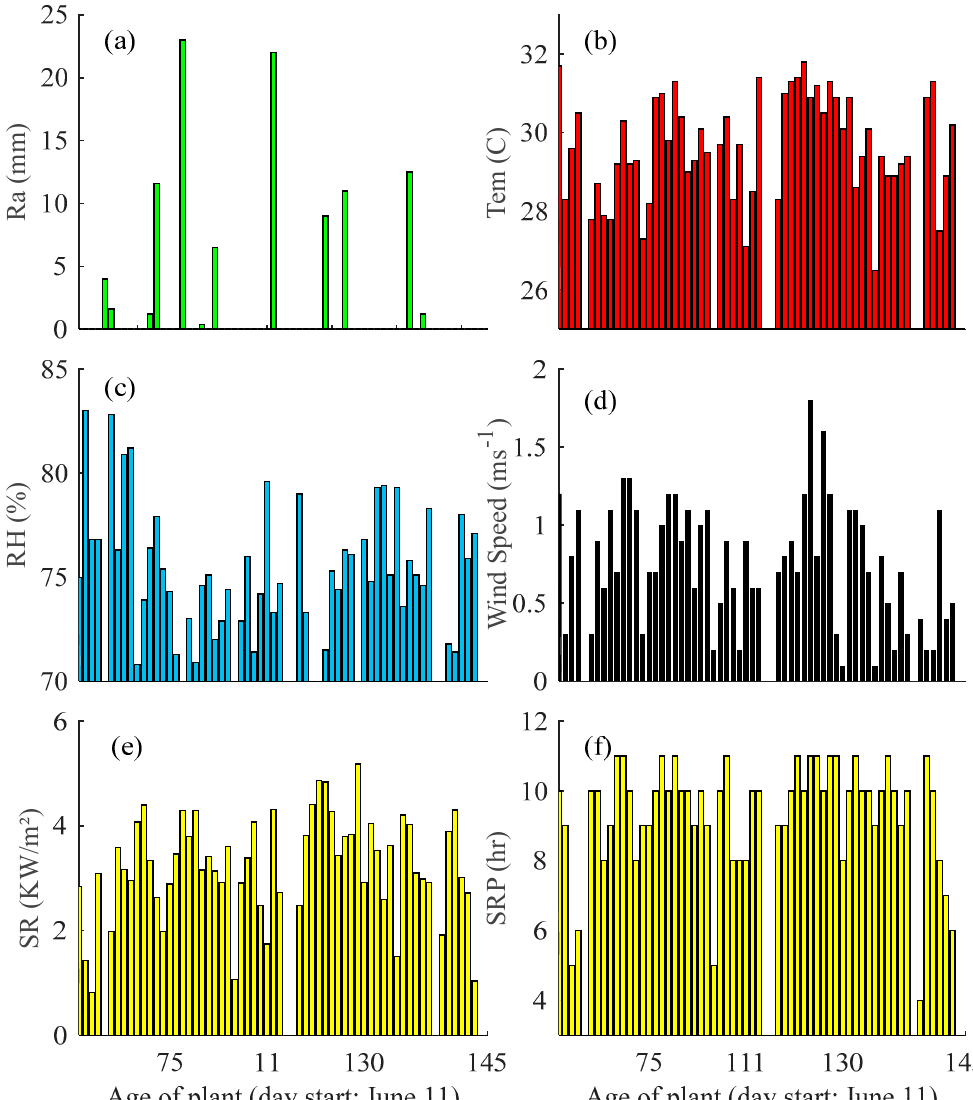
Figure 6. Meteorological data collected by an Automatic Weather Station at the study side during the project period. ( a ) Rainfall (Ra), ( b ) temperature (Tem), ( c ) relative humidity (RH), ( d ) wind speed, ( e ) solar radiation (SR), and ( f ) solar radiation period